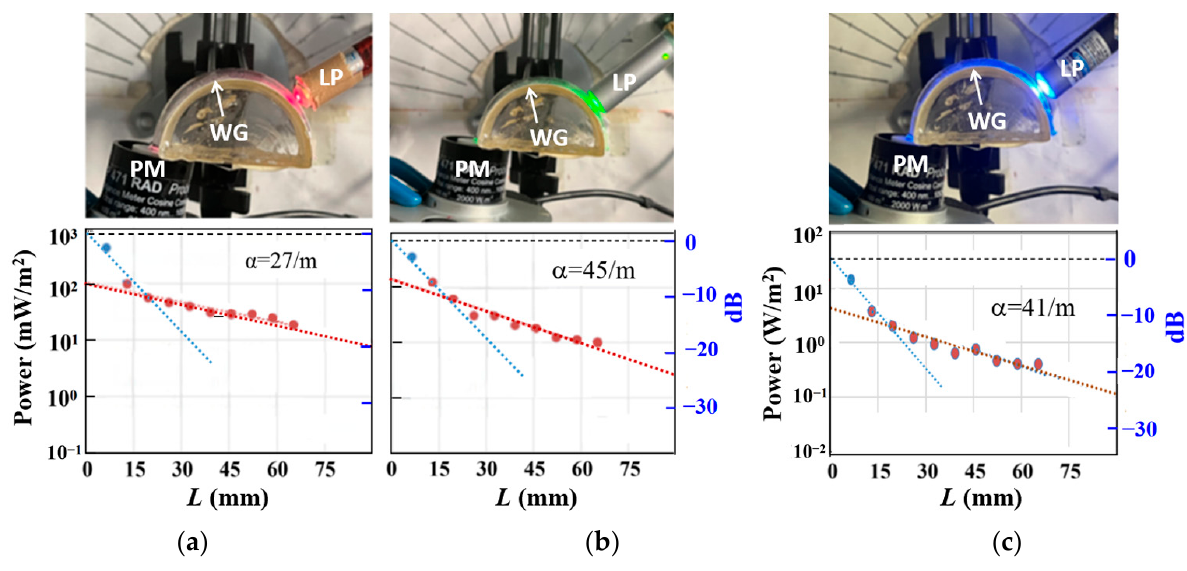
Figure 5. Cylindrical RSC waveguide experiment. The power of guided light is plotted as a function of the distance along the curved waveguide for ( a ) red, ( b ) green, and ( c ) blue lasers. For red, α = 27/m; for green, α = 45/m; for blue, α = 41/m. The right ordinates show the power loss in dB. On top of each plot is shown a picture of the corresponding experiment; LP is the laser pointer, PM is the power monitor, and WG is the cylindrical waveguide, the inner side of which is covered with white paper followed by aluminum foil.